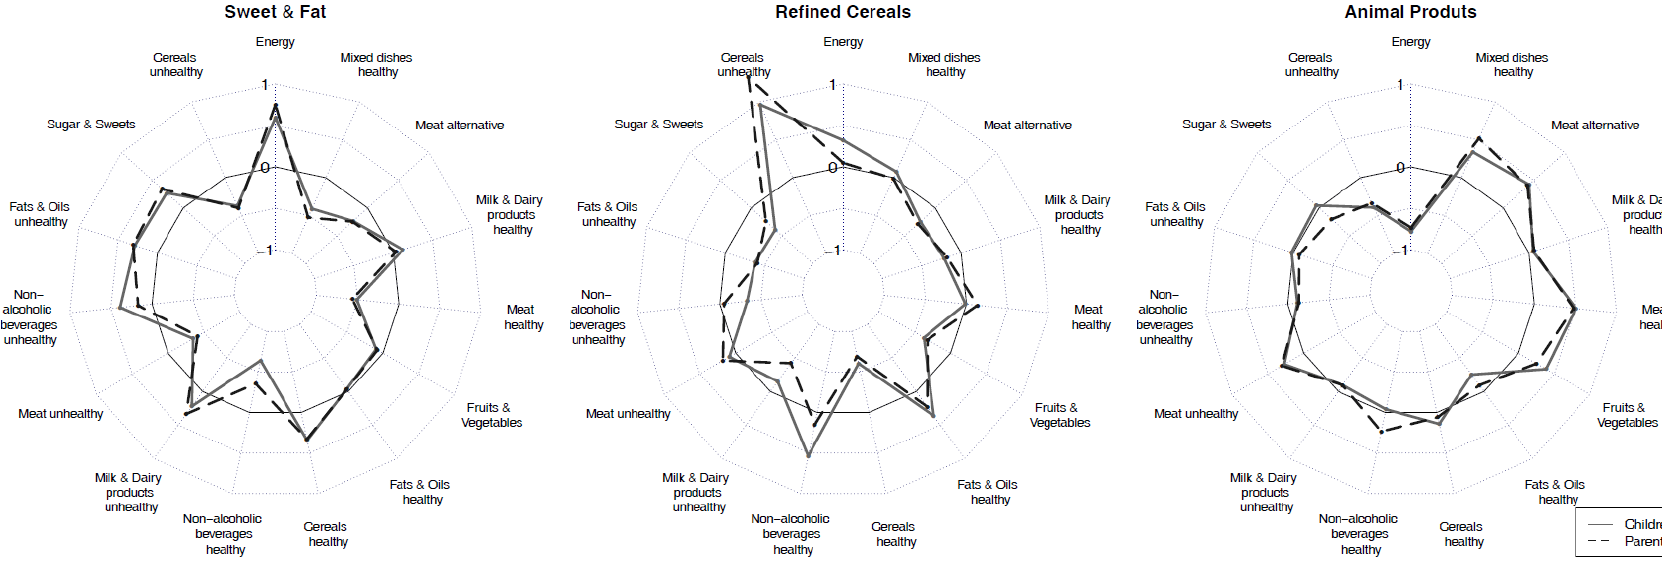
Figure 1. Dietary patterns of children and their parents: Sweet and Fat, Refined Cereals, and Animal Products. Mean z ‐ scores of percentage of energy intake of different food groups in the three clusters for children and parents are shown (for details, see Table 2). The scale ranges from − 1 to 1 with tick lines for − 0.5, 0 (solid line) and 0.5.